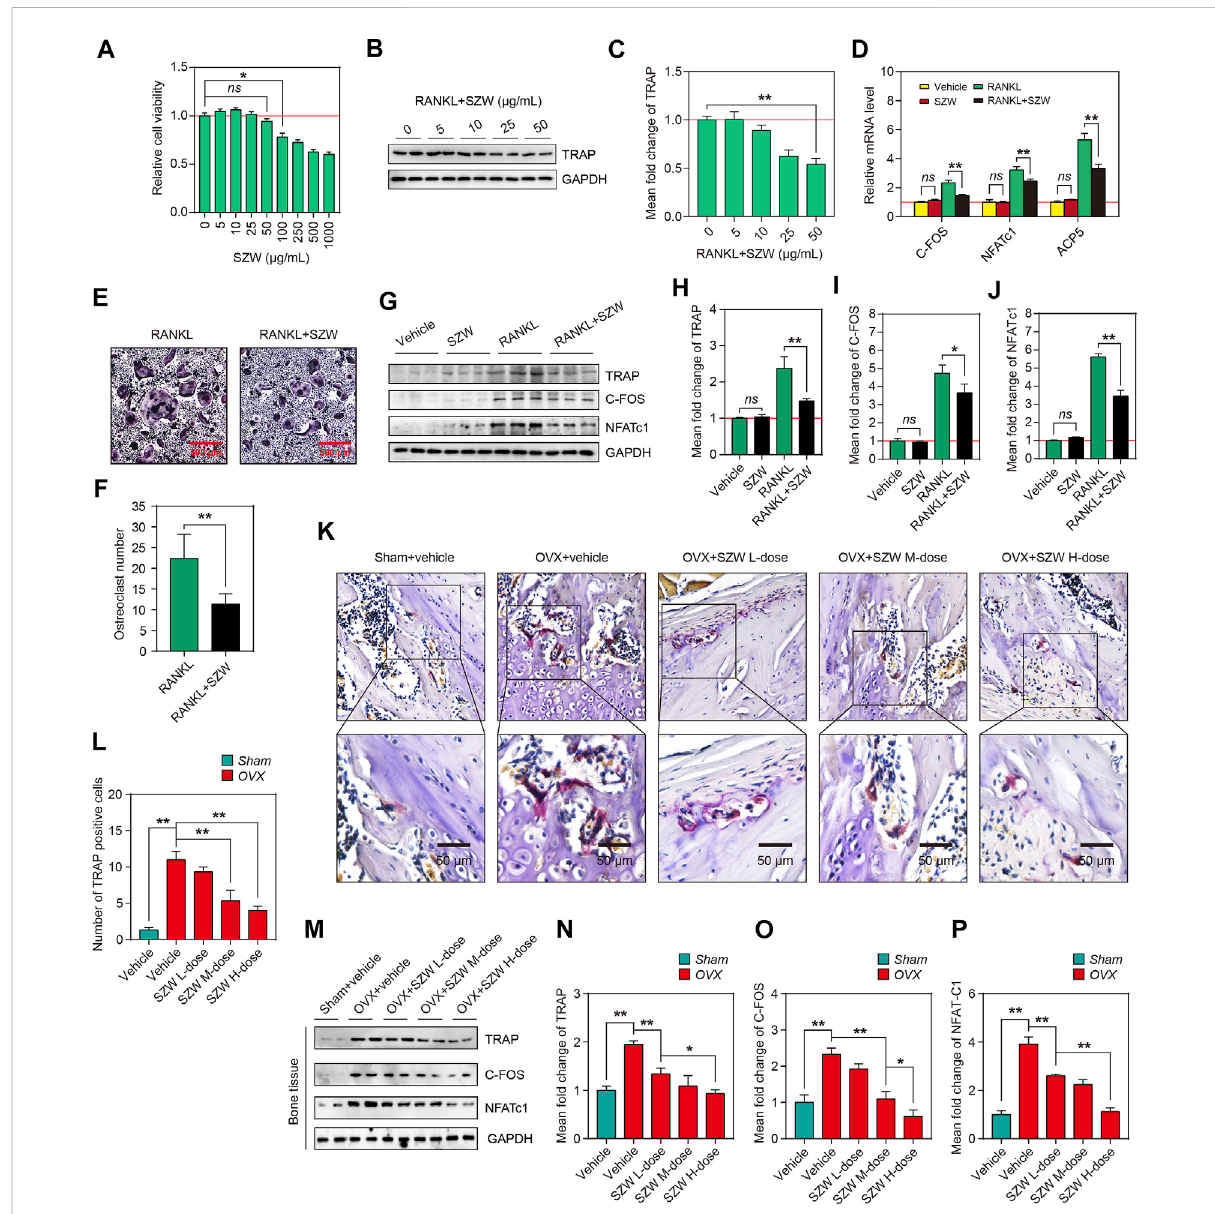
FIGURE 2 SZW inhibited osteoclastogenesis in vitro and in vivo . RAW264.7 cells were treated with different concentrations of SZW (0, 5, 10, 25, 50, 100, 250, 500 and 1000 μ g/ml) for 24 h (A) The viability of RAW264.7 cells was determined by the CCK-8 assay. Values of treatment groups were normalizedtothecontrolgroup(representing100%cellviability).Dataareexpressedasthemean±SEM(n=6) (B) Westernblottinganalysisshowing the changes in TRAP protein levels in RAW264.7 cells (C) The mean fold change of TRAP expression level was quanti fi ed using ImageJ (D) RT- PCR analysis of the mRNA levels of osteoclastogenesis-related genes, NFATc1, ACP5, and C-FOS, in the control RAW264.7 cell and RAW264.7 cell treatedwithRANKLandRANKL+SZW.Dataareexpressedasthemean±SEM(n=3) (E) RepresentativeimagesofTRAPstainingofRaw264.7cells (F) The number of osteoclasts in the indicated groups (G) Representative western blotting images showing TRAP, C-FOS, and NFATc1 expression in RAW264.7cells (H – J) The mean fold changes of TRAP, C-FOS, and NFATc1 expression levels werequanti fi edusing ImageJ (K) Representative TRAP stainingimagesoffemursections (L) RelativeTRAPintensitywasquanti fi edusingImageJ (M) RepresentativewesternblottingimagesshowingTRAP, C-FOS, and NFATc1 protein levels in femur tissues of rats (N – P) The mean fold changes of TRAP, C-FOS, and NFATc1 protein levels were quanti fi ed using ImageJ. Data are expressed as the mean ± SEM (n = 3). p p < 0.05, pp p <